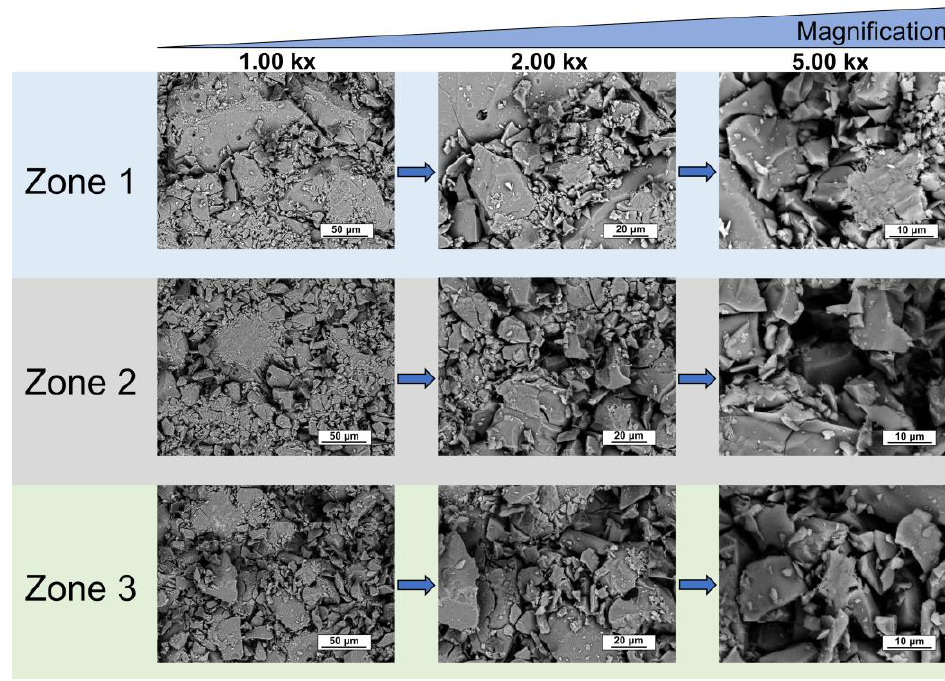
Figure 5. SEM images of different zones of Mn,Sr-TCP powder at various magnifications.